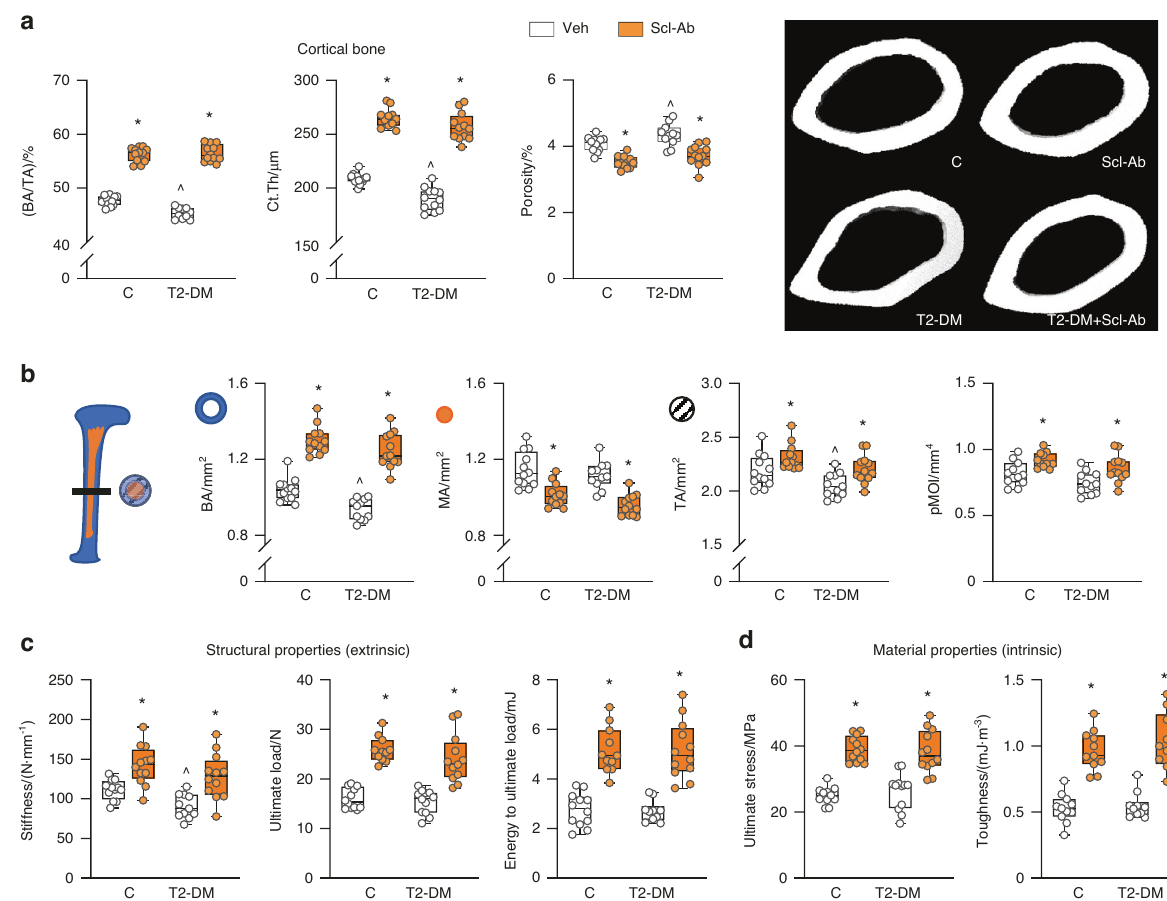
Fig. 6 Scl-Ab restored and further increased cortical bone volume and improved microarchitecture and extrinsic and intrinsic bone properties in both control and diabetic mice. Micro-CT analysis of femur bone microarchitecture and 3-point bending analysis of bone strength after (t4) treatment with Scl-Ab. a Cortical bone area/tissue area (BA/TA), thickness (Ct.Th) and porosity and representative images. b Bone area (BA), medullary area (MA), total area (TA) and polar moment of inertia (pMOI). c Bone biomechanical properties (stiffness, ultimate load, and energy to ultimate load) and d bone material properties (ultimate stress and toughness). For all analyses, n = 10 – 12 mice per group. Data are presented as box & whisker plot where each dot represents a mouse. ^ P < 0.05 versus control LFD mice and * P < 0.05 versus respective vehicle-treated mice by two-way ANOVA with post hoc Bonferroni ’ s correction for multiple marrow area whereas ABL increased tissue area, with the Based on the underlying mechanisms of the skeletal disease in consequent change in bone geometry and polar moment of diabetes, bone anabolic agents capable of increasing bone inertia, leading to increased strength with ABL. Overall, PTH and formation and repairing the lost bone should be preferred ABL increased to a similar extent BFR on all bone surfaces. Thus, compared to antiresorptive agents. We indeed demonstrate in the higher levels of the bone formation marker P1NP in the current study the effectiveness of two bone anabolic response to the high dose of ABL a priori cannot be attributed pathways: activation of the PTH1R and neutralization of the to overall changes in BFR at the tissue level. However, ABL osteocyte-derived inhibitor of bone formation sclerostin. Our fi ndings are consistent with post hoc analysis of large clinical compared to PTH induced a greater increase in MAR, one of the components of BFR, on the periosteal surface of cortical bone, osteoporosis trials demonstrating that teriparatide, ABL, or leading to the changes in bone geometry. Therefore, higher romosozumab increased BMD and trabecular bone score and reduced non-vertebral fracture incidence similarly in diabetic and non-diabetic patients. 28 – 31 We compared and contrasted for the fi rst time the ef fi cacy of two anabolic ligands of the PTH1R: PTH(1-34) and ABL on restoring bone health in established diabetes, and found that ABL is more potent and provides better bone geometry bene fi ts compared to PTH. Thus, half a dose of ABL was suf fi cient to restore bone mass, increase bone formation, and correct architectural deterioration and bone strength in diabetic mice to a similar extent than PTH, and the equimolar dose of ABL did not provide additional advantages compared to the half dose. In addition, although both PTH and ABL restored cortical bone thickness, they acted on different surfaces, as PTH reduced half dose of ABL induced a similar response. Furthermore, the high